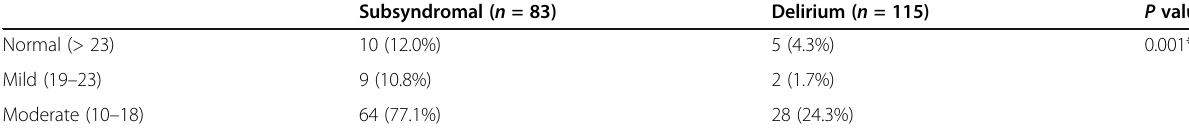
Table 3 Relation between cognitive impairment and confusion in patients with delirium and SSD Subsyndromal ( n =